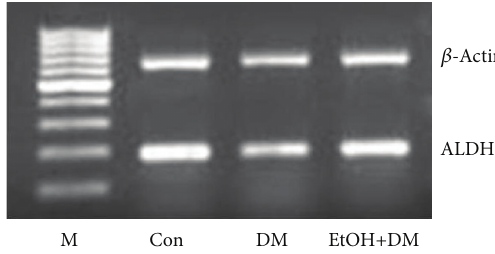
Figure 4: ALDH2 mRNA expression by RT-PCR.